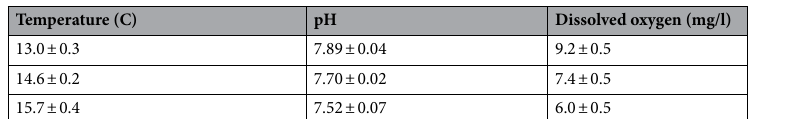
Table 4. Mean and standard deviation of the temperature, pH, and DO conditions measured by YSI sensors in the replicate aquaria over the duration of the